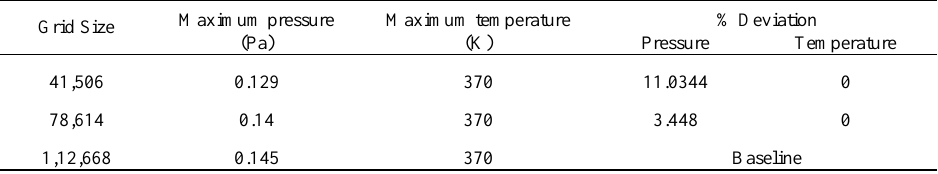
Table 1. Grid independence